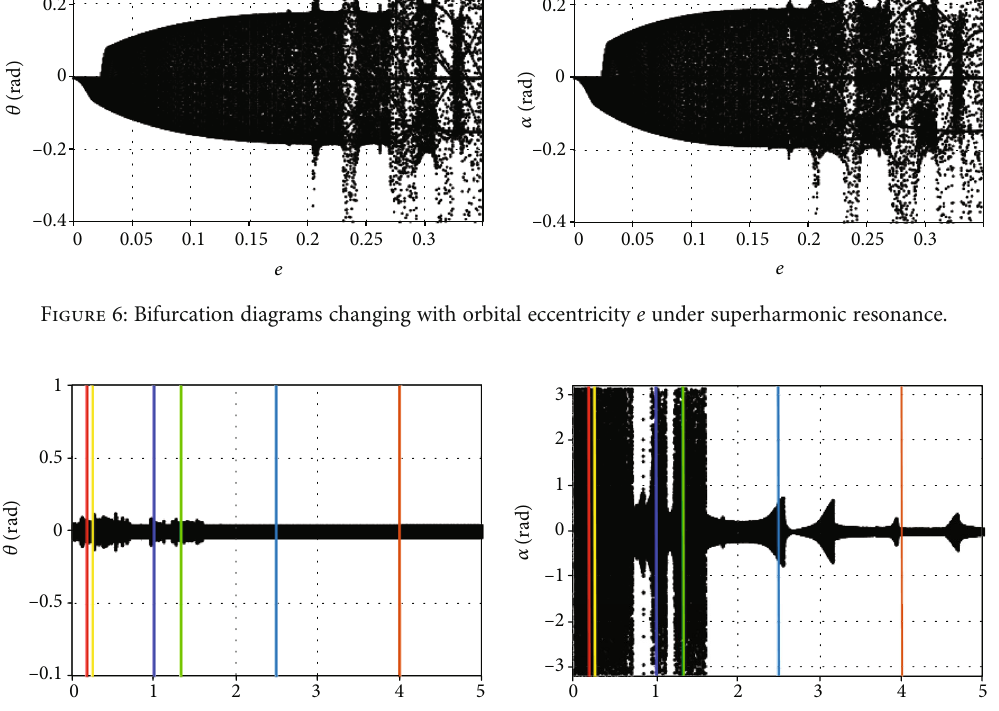
Figure 7: Bifurcation diagrams changing with parameter β Table 3: The values of parameter β 2 corresponding to every resonance type at β 1 = 1/3 . The value of Frequency The value of ω β relationship 2 2